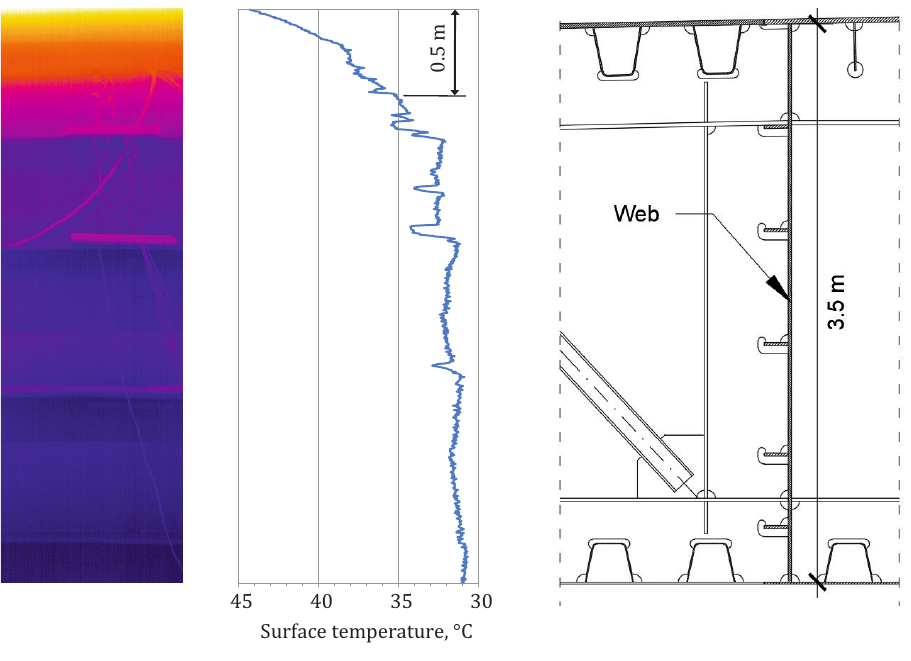
Figure 11. Thermogram and temperature profile of the internal web, 26 June 2019, time 13:30. Visible effect of solar heating – high temperature in the upper part of the